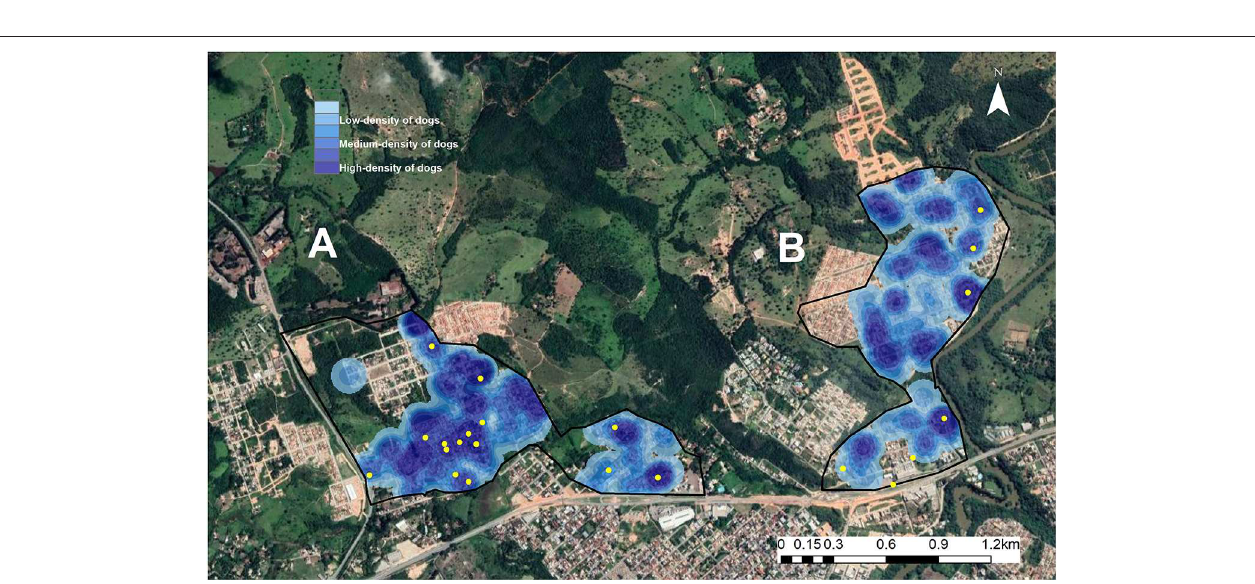
FIGURE 1 | (A,B) Land cover and spatial distribution of free-roaming dogs in two areas of Divinópolis, MG, Brazil, studied during the period 2012 to 2014. Zones with high-density vegetation are shown in green, transition zones with medium-density vegetation in yellow and orange, and urbanized zones with absence of vegetation in red. The white dots represent dog capture locations.